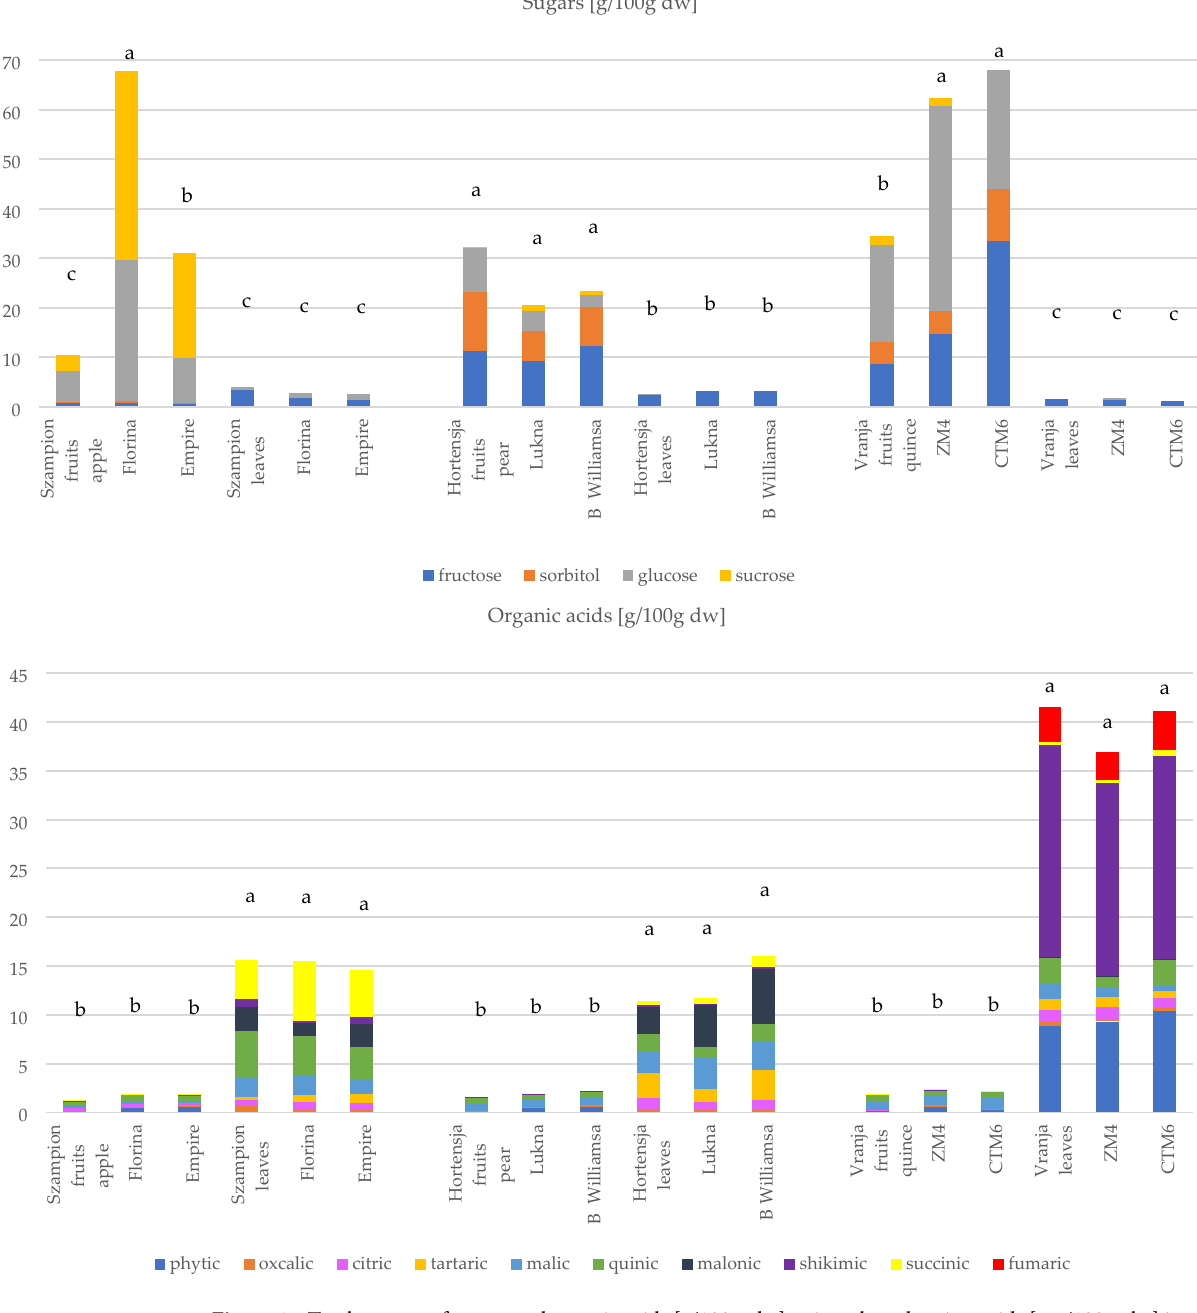
Figure 1. Total content of sugars and organic acids [g/100 g dw], minerals and amino acids [mg/100 g dw] in fruits and leaves of some selected species and cultivars. Mean of 3 replications ± standard deviation followed by the same letter were significantly different (p < 0.05) according to Tukey’s least significant differences test; Letters a,b,c,d, represent significance in content (p <